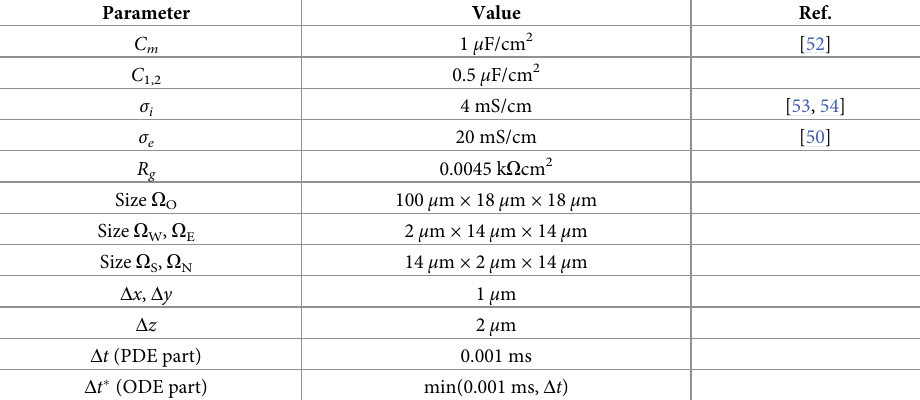
Table 1. Default parameter values used in the simulations. For the parameters used in the Grandi et al. model, we refer to [55]. Parameter